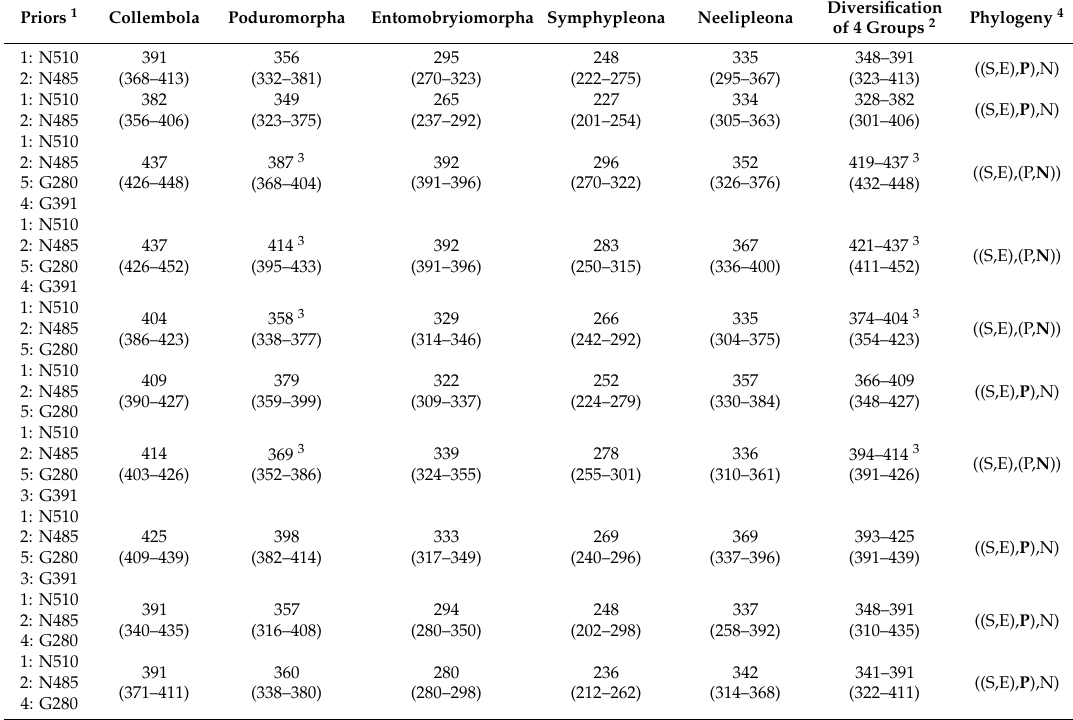
Table 2. Calibration points and estimated age, with 95% Highest Posterior Density (HPD), in My of key groups. Dates refer to the crown group, not including the